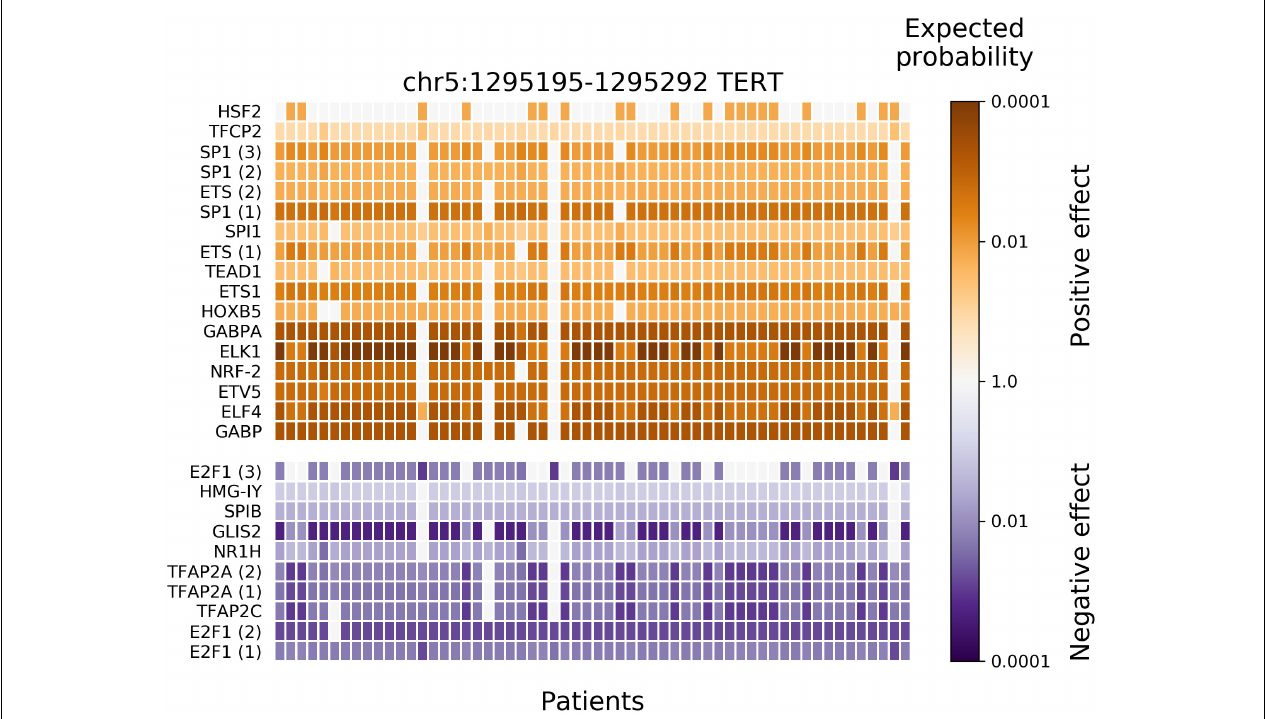
FIGURE 3 | Results of new BayesPI-BAR2 package – TFs significantly affected by skin cancer somatic mutations in the TERT promoter mutation block. The heatmap displays the distribution of predicted TF binding effects of TERT promoter somatic SNVs across 58 skin cancer patients. The columns represent patients, the rows represent predicted significantly affected TFs, and the color represents the binding effect size. Reduced binding is shown in blue and increased binding in orange. The color shade represents the log 10 -scaled fraction of background δ dbA values which are more extreme than the observed δ dbA of a patient, which is an indication of effect size. The darker cells the larger effect. Some TFs are represented by multiple PWM models, their instances are indicated by a number in parentheses. Only significantly affected TFs (Wilcoxon rank-sum test P -value < 0.001 after Bonferroni correction) are shown. The following TFs belong to the ETS family (Gutierrez-Hartmann et al., 2007): GABP α , ELF4, ETV5, ELK1, ETS1, SPI1, and SPIB. Here, background mutation model in BayesPI-BAR2 is based on tumor